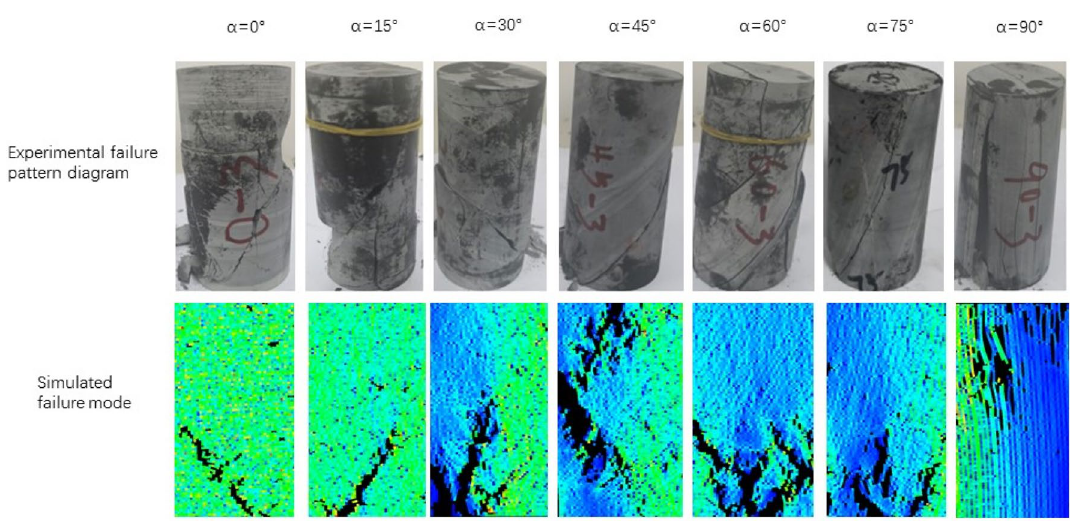
Figure 24. Comparison of phyllite uniaxial compression test and simulated failure